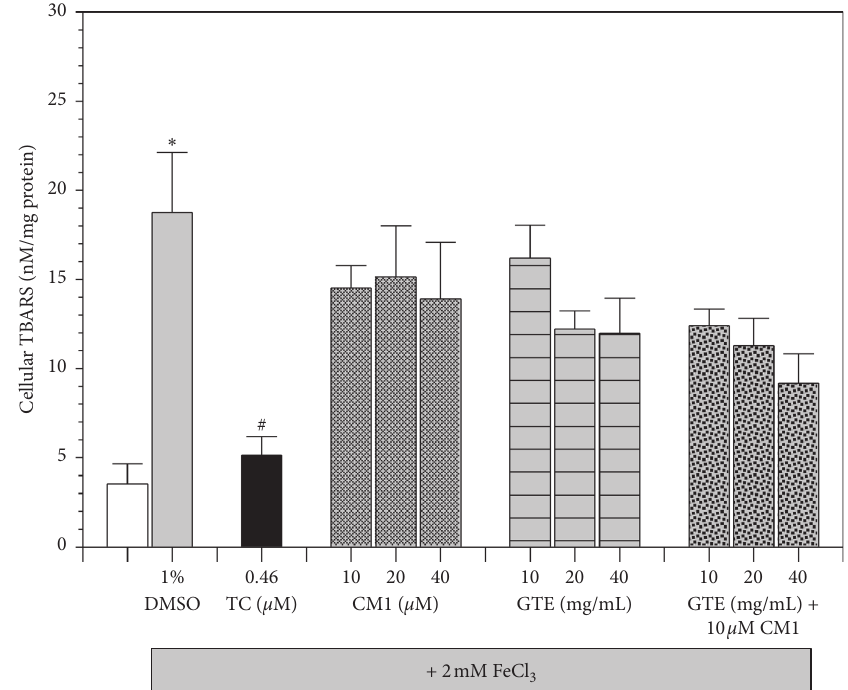
Figure 5: Levels of TBARS in SH-SY5Y cells after being exposed to treatments with or without 2mM FeCl DMSO, TC (0.46 μ M), CM1 (10–40 μ M), GTE (10, 20, and 40mg/mL equivalent to 5.24, 10.48, and 20.96 μ M EGCG, respectively), and a combination of GTE and CM1 for 24h. Data obtained from three independent duplicate experiments are expressed as mean ± SEM values. ∗ P < 0 . 05 when compared to the untreated cells without iron loading; # P < 0 . 05 when compared to the iron-loaded cells treated with 1%